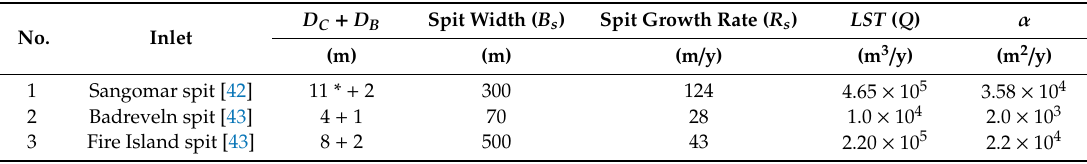
Figure 15. According to the study by [42], the averaged LST along the 20 km-long Sangomar spit from 1927 to 1987 was estimated to be around 465,000 m 3 / y. Meanwhile, the average LST at the Fire Island spit from 1933 to 2010 and the 3 km-long Badreveln spit from 1916 to1994 were, respectively, estimated to be about 220,000 m 3 / y and 10,000 m 3 / y [43]. As can be seen from this figure, these measured data points are comparable with the corresponding contour line that derived in the current study. Table 4. Summary of the morphodynamic characteristics of the spit at Sangomar, Badreveln and Fire Island inlets.